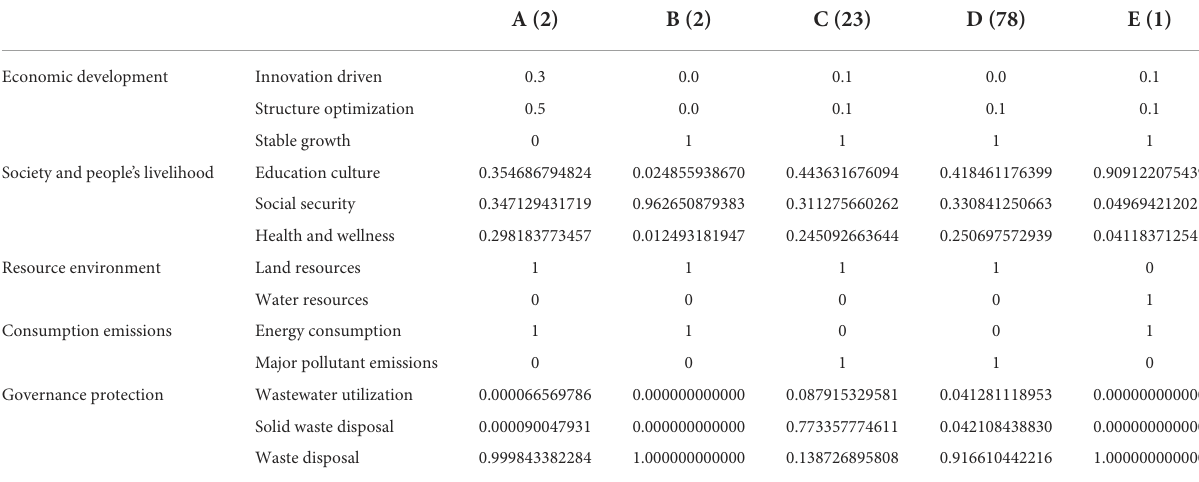
TABLE 7 Intermediate layer clustering